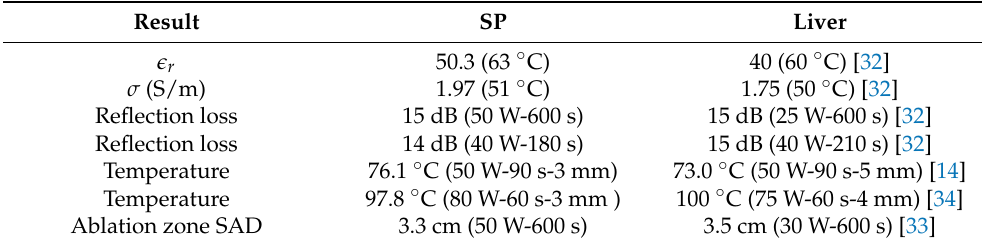
Table 4. Comparison between SP and animal liver